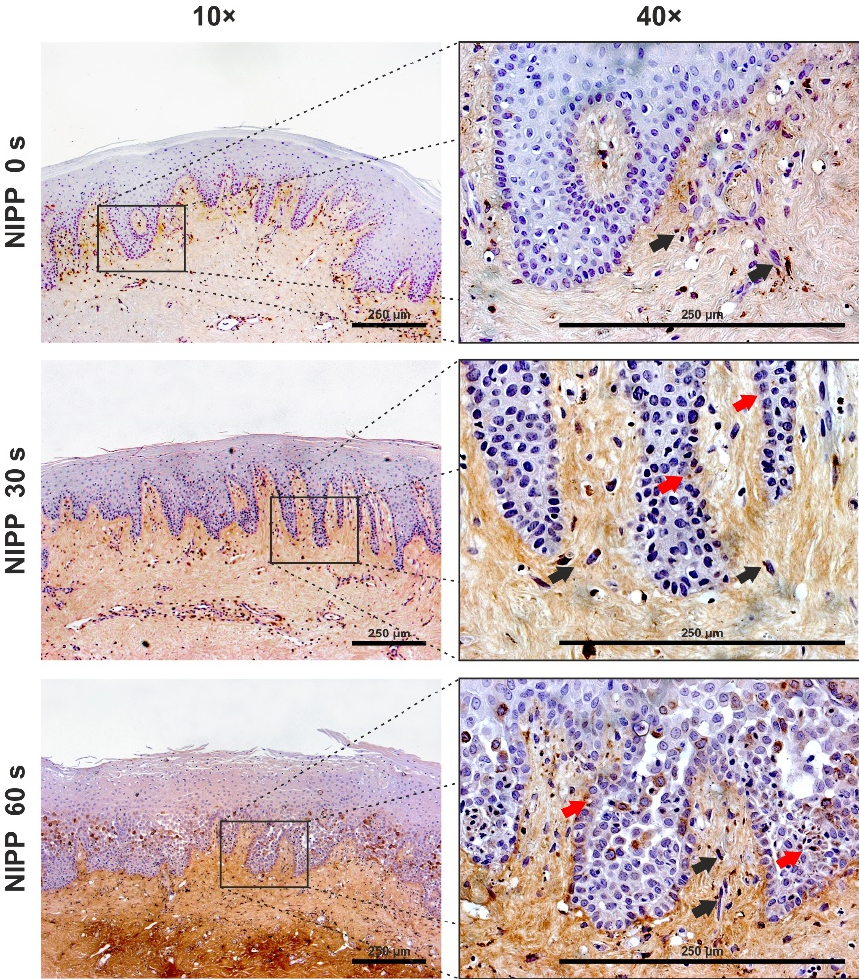
Figure 9. Influence of NIPP on gingival tissue biopsies at 24 h after NIPP treatment for 30 s and 60 s, as compared to the untreated group (NIPP 0 s). MMP1 staining, original magnification 10× and 40×. Red arrows: positively stained HGK, black arrows: positively stained HGF. The scale bar represents 250 µm.